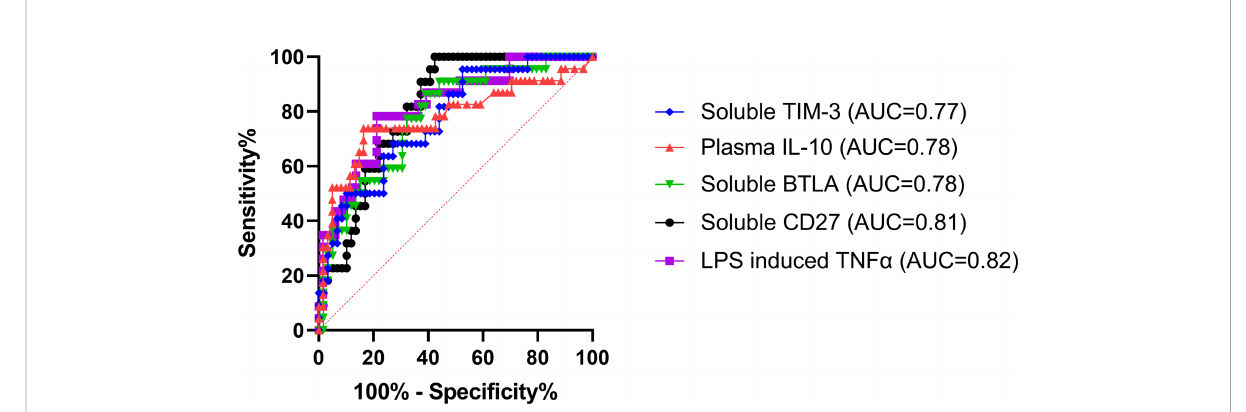
FIGURE 5 Receiver operating characteristics curve analysis within the fi rst 72 hours following pediatric thermal injury. The area under the receiver operating characteristic curves was highest for LPS-induced TNF a production capacity (0.82; purple) and soluble CD27 (0.81; black). This was followed by soluble BTLA (0.78; green), unstimulated plasma IL-10 (0.78; red), and soluble TIM-3 (0.77; blue). The remaining markers (CD4+, Tregs, CD14+, %HLA-DR expression, plasma IL-6, plasma IL-8, and PHA IL-10) had an AUC ≤ 0.75 (Supplemental Table 1). The optimal threshold for the prediction of the development of a nosocomial infection was for <505.8 pg/mL for LPS-induced TNF a , >1129 pg/mL for soluble CD27, >1353 pg/mL for soluble BTLA, and >705.3 pg/mL for soluble TIM-3, and >11.59 pg/mL for plasma